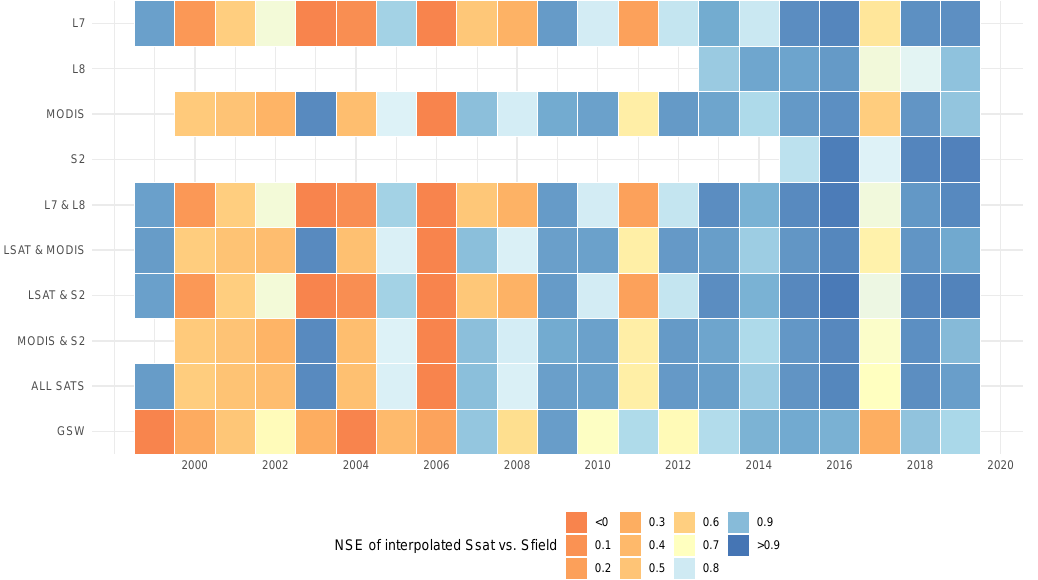
Figure 15. Heat map of the NSE values per year between daily interpolated remotely sensed flooded areas and ground truth data from each sensor, multi-sensor combinations and published Global Surface Water datasets